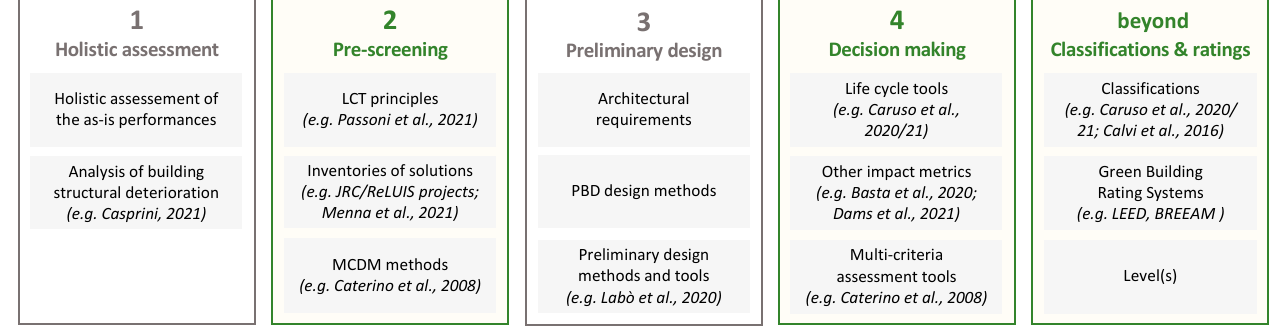
Figure 2. Sustainable Building Renovation (SBR) framework: graphical state of the art.